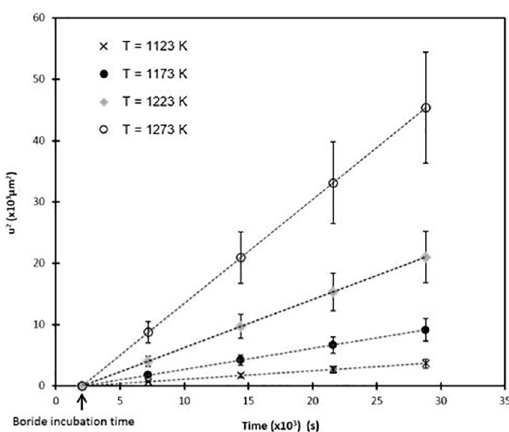
Figure 7. Square of boride layer thickness as a function of boriding time for increasing temperatures